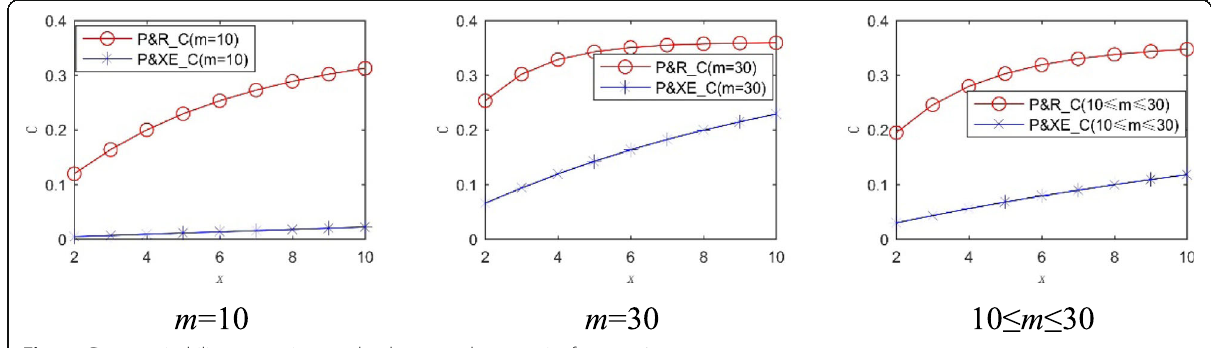
Fig. 17 Data survivability comparison under the same data security for n =